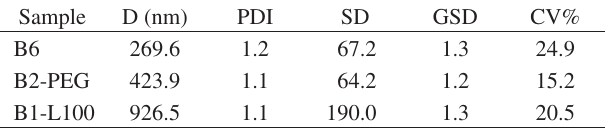
Table 2. Results obtained by SEM (D: average diameter; PDI: polydisper- sion index; SD: standard deviation; GSD: geometric standard deviation; CV: variance coefficient).